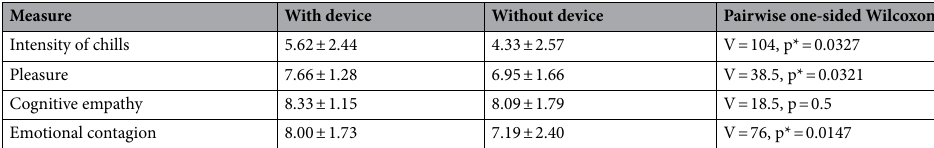
Table 1. Comparison of the intensity of chills, sharing of the speaker’s feelings, sharing of the speaker’s viewpoint, and perceived pleasure with and without the device.